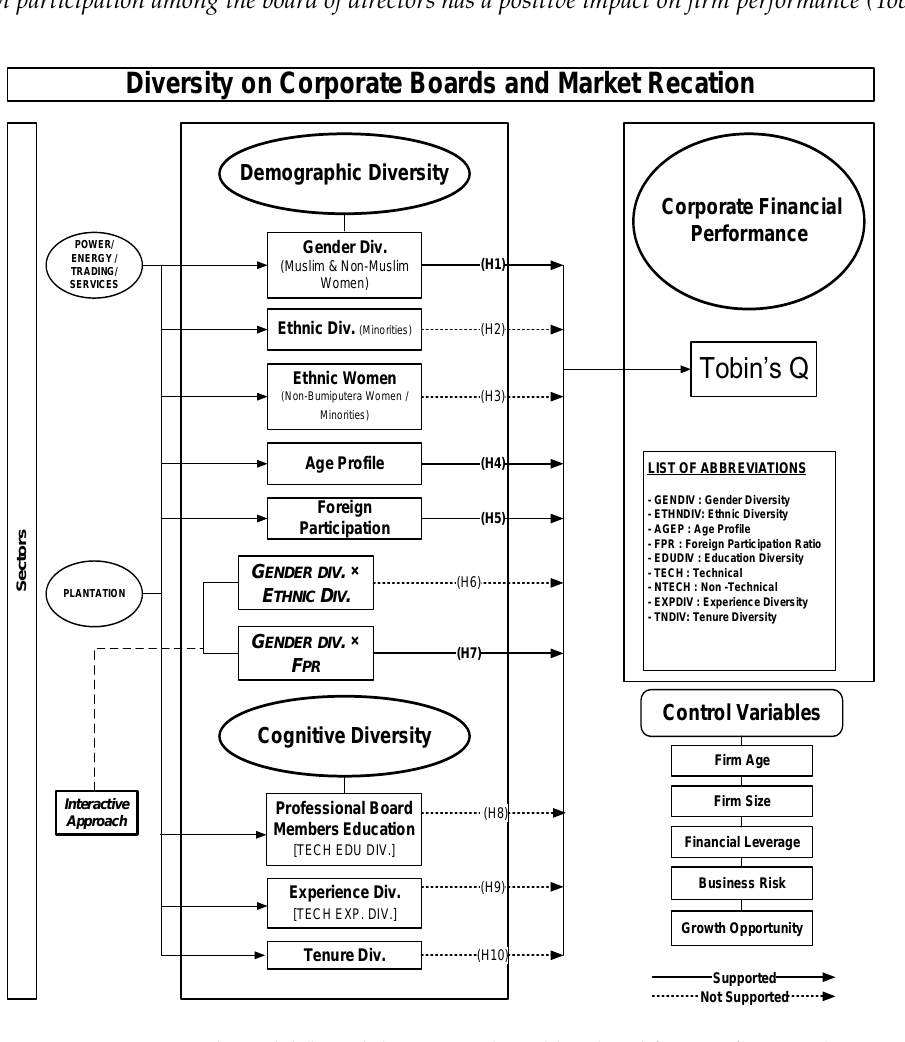
Figure 1. Research model (board diversity at board level and firm performance).